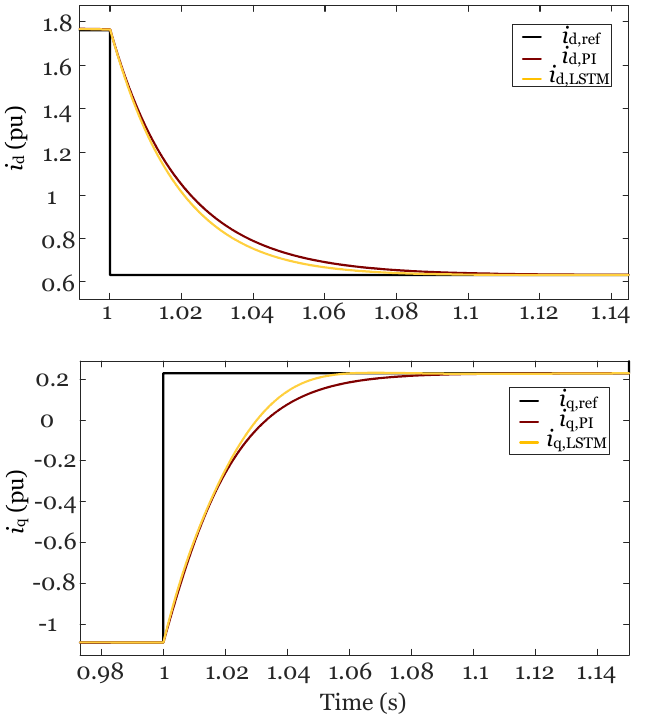
Figure 8. Controller response to step changes in i d , ref and i q , ref . ( a ) i d , ref change; ( b ) i q , ref